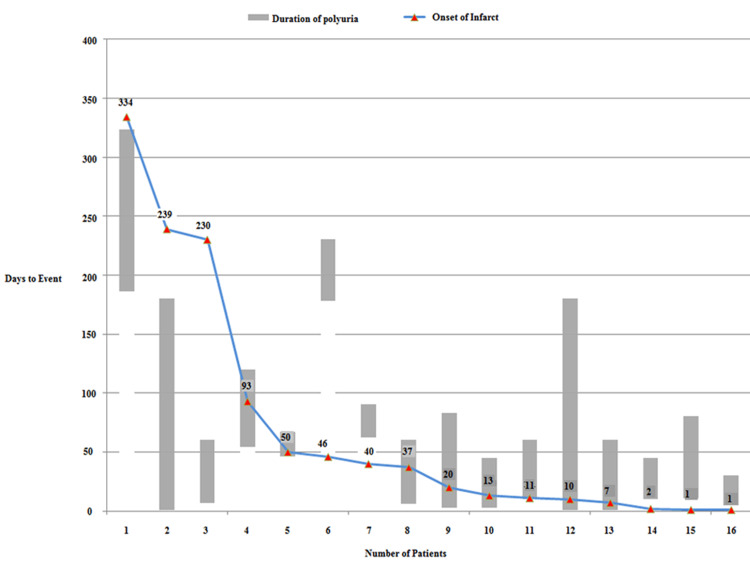
Duration of polyuria and onset of stroke in tuberculous meningitis patients with cerebral salt wasting (CSW).The vertical grey bars denote the onset (lower limit) and subsidence (upper limit) of polyuria in each patient. The red traingles denote the day of stroke after admission. A total of 10 out of 16 patients developed stroke during CSW (high urinary output). (Reproduced from Misra UK, Kalita J, Kumar M,
et al.: Hypovolemia due to cerebral salt wasting may contribute to stroke in tuberculous meningitis.
QJM. 2018; 111(7): 455–60. with permission).